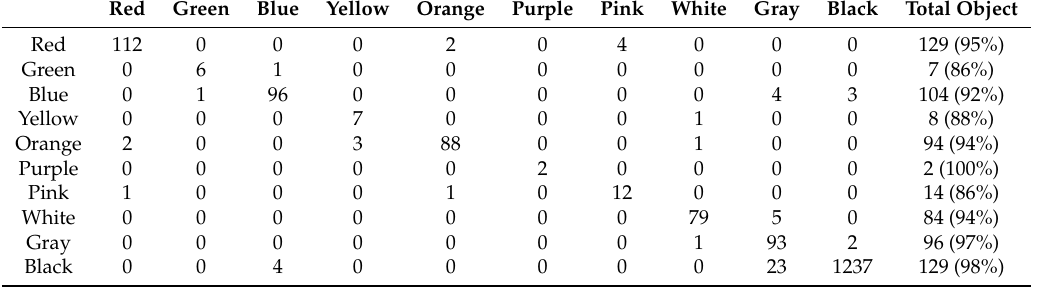
Table 3. Result of the classification based on the color.